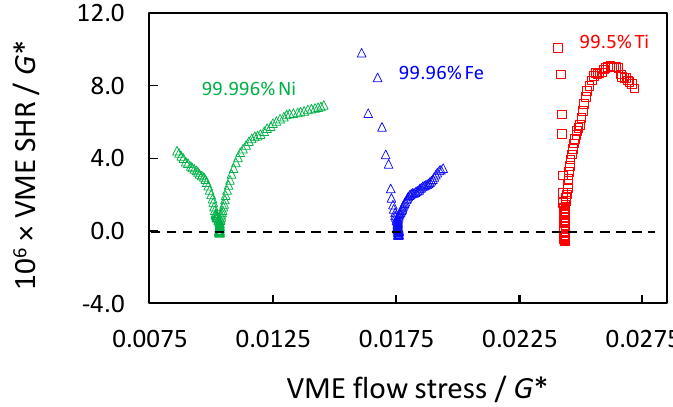
Figure 7. The stress–strain behavior of pure fcc Ni, bcc Fe, and hcp Ti ultra-deformed by torsion under (very) high pressure (HPT) (respectively 2, 6, and 2 GPa applied pressure) at room temperature beyond VME strains of 1000. The VME flow stress has been measured as HV / 3, which is one-third of the Vickers microhardness. Replotted from Edalati [56]. The HPT curve of fcc Cu (6 GPa axial pressure) is from Edalati et al. [57]. Dotted lines are the average Stage IV apparent saturation flow stress of metals of similar composition deformed by ECAP in the range 8 ≤ ε ≤ 16 (Figure 6). Homologous deformation temperatures are indicated in the figure. The SFE of the four materials at RT increase in the inverse order of their homologous deformation temperature from approx. 45 mJ / m − 2 of Cu to approx. 180 mJ / m − 2 of Ti.